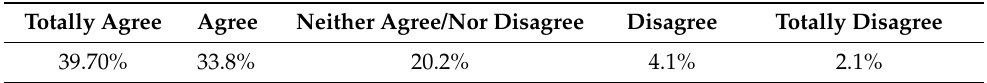
Table 4. Responses on whether climate change is caused by human actions. Q: Is it true, from your point of view, that human activity is the main cause for climate changes? Totally Agree Agree Neither Agree/Nor Disagree Disagree Totally Disagree 39.70%